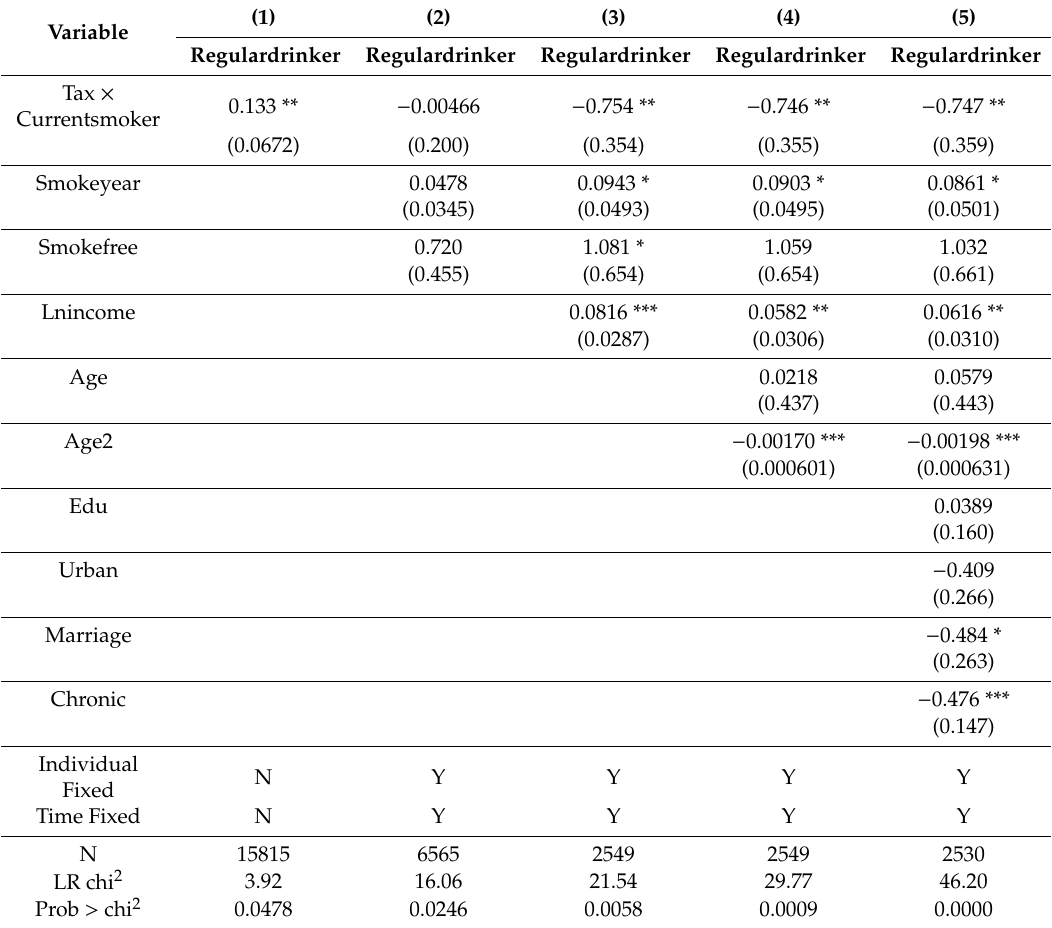
Table 3. Regular drinking behavior responses to the cigarette